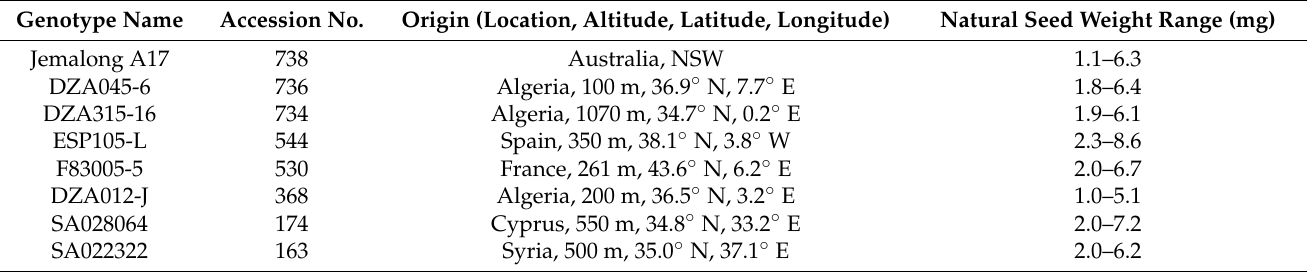
Table 1. Medicago truncatula accessions used in this work. Accession number refers to the reference number at the Medicago Biological Resource Centre (INRAe, Montpellier,